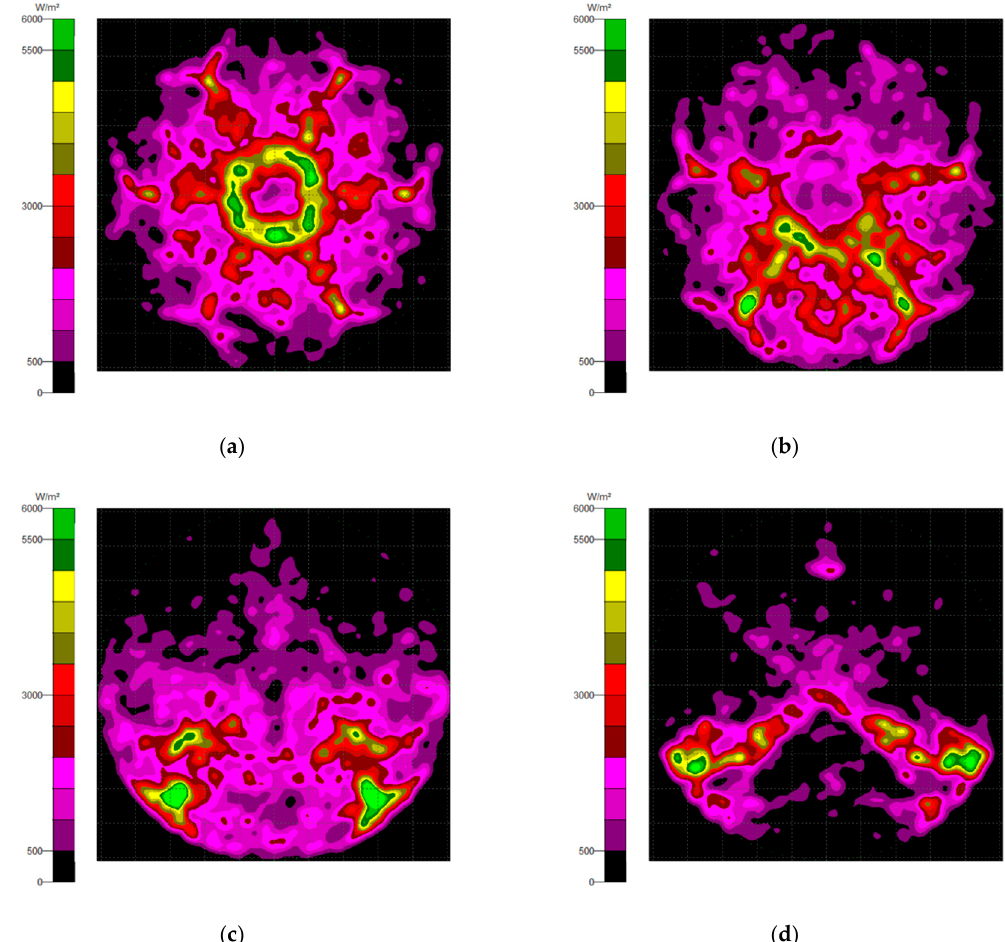
Figure 22. The irradiance distribution of the solid-NACPC and new elliptical collimator with misalignment angles of ( a ) 0°, ( b ) 10°, ( c ) 20°, and ( d ) 30°.